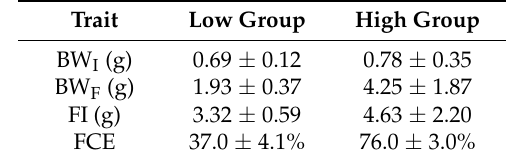
Table 4. Descriptive statistics of feed conversion efficiency and relevant traits in crucian